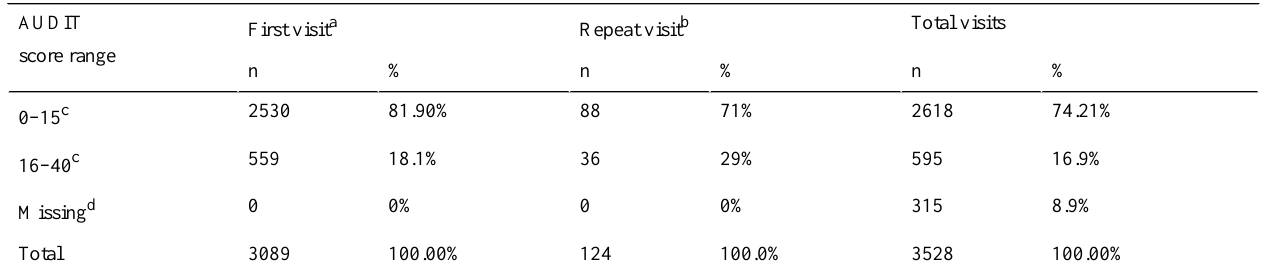
Table 3. Alcohol Use Disorders Identification Test (AUDIT) score for college and university students during their first or repeat visit to the website